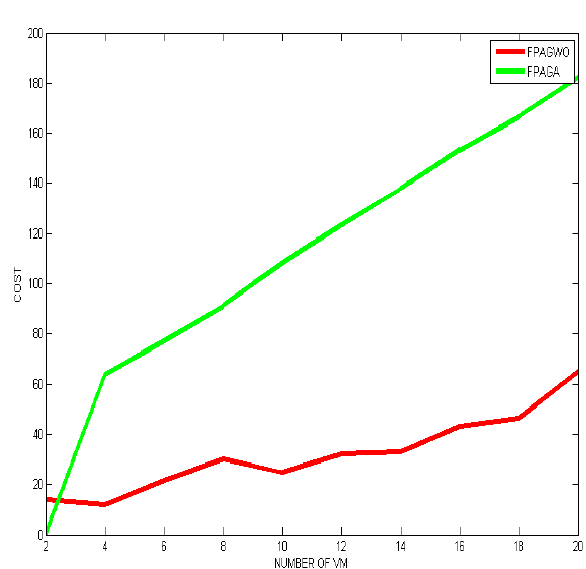
Figure 3. Cost on LIGO workflow for FPA_GWO and FPA_GA